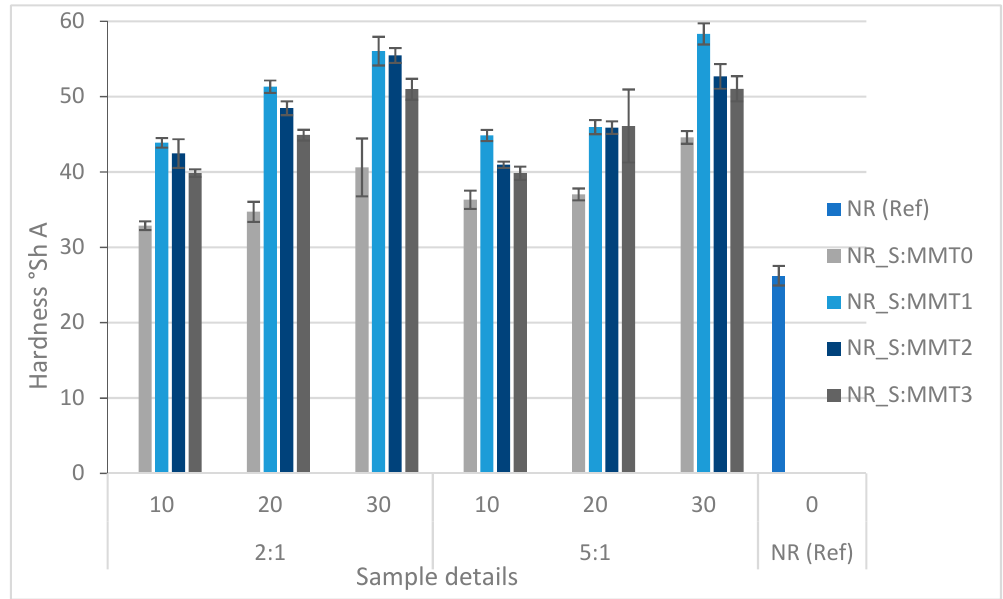
Figure 14. Influence of the type of biofiller and its content on the hardness values of composites at the straw:montmorillonite ratio 2:1.